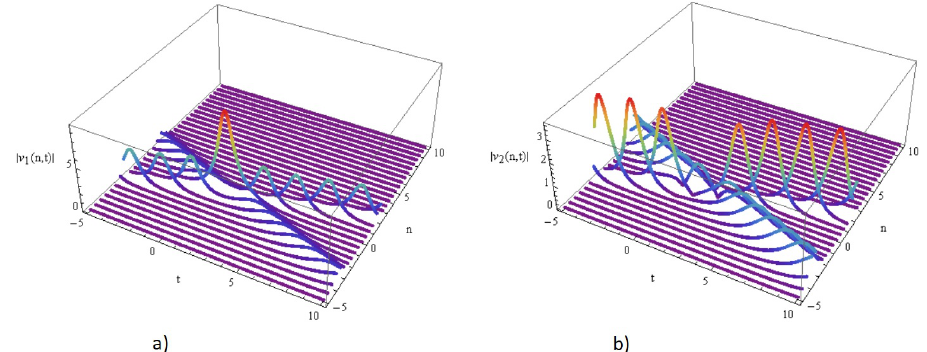
Figure 1. Plots of | v 1 ( n , m ) | = | G 1 / F 1 | (a) and | v 2 ( n , m ) | = | G 2 / F 2 | (b) given in (8), the absolute values of the 2-ss for the focusing semidiscrete cmKdV with two coupled equations (4), for the chosen